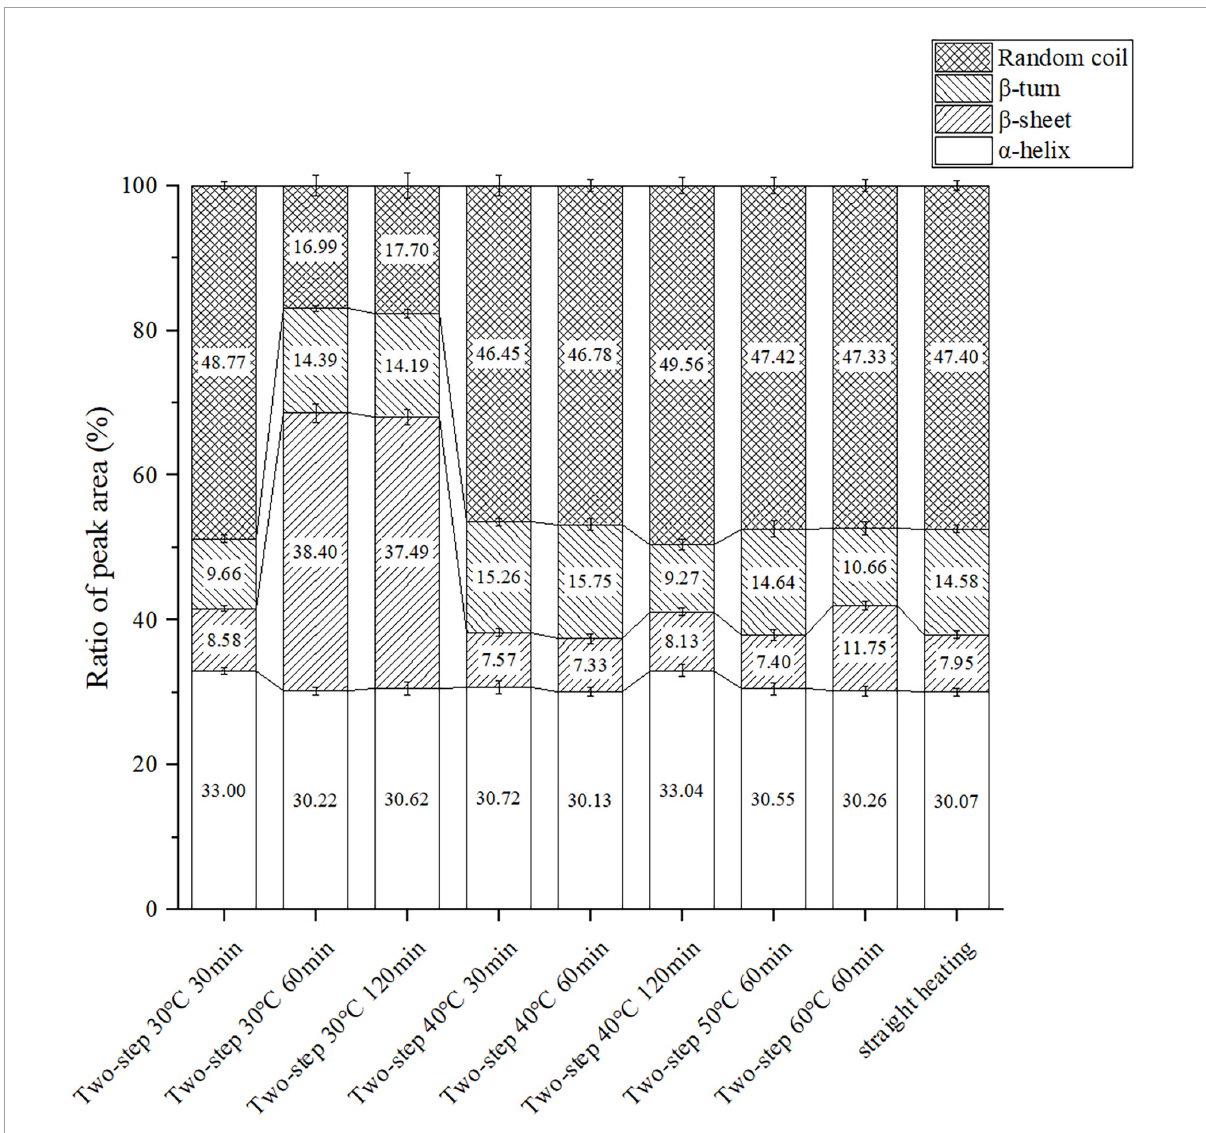
FIGURE6 Changes of the protein secondary structure content under different heating conditions. Data were obtained as the mean ± standard deviation ( n =